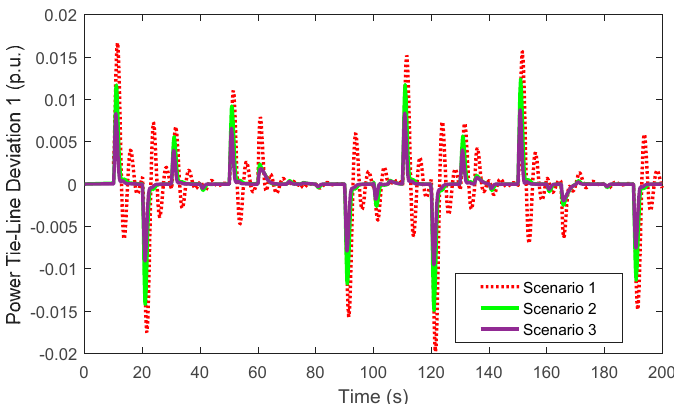
Figure 14. Comparison of the exchange tie-line power deviations between microgrids 1 and 2 in the three scenarios.